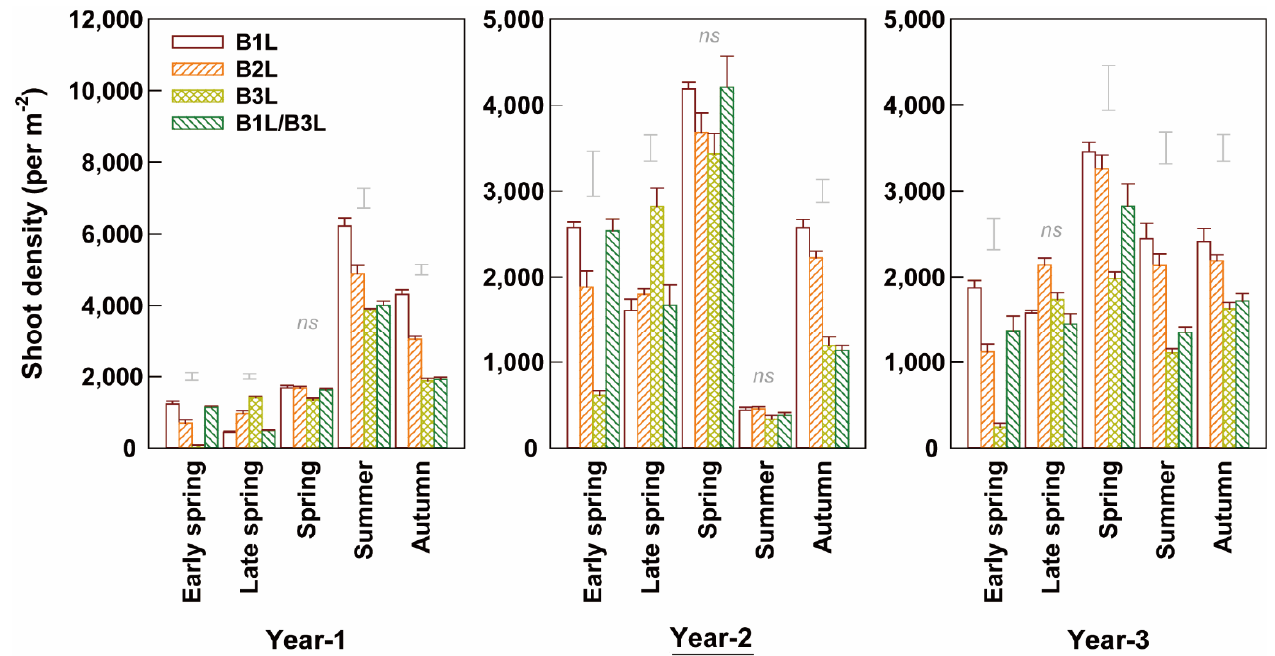
Figure 2. Density levels of young shoots harvested at different standards in early and late spring, summer, and autumn over three experimental years (means ± standard errors, n = 4). Single bars without data points located above columns are LSD values indicative of significant ( p < 0.05) differences between harvest standards in the specified season. The symbol ‘ ns ’ above columns indicates no significant difference between four harvest